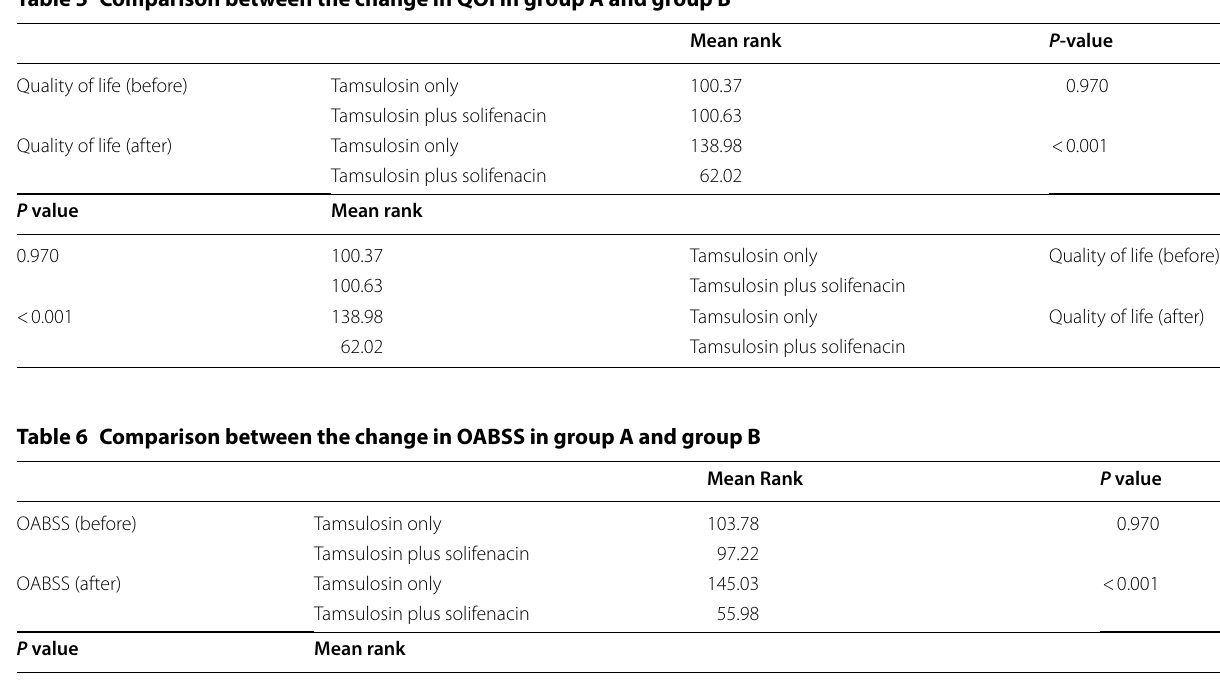
Asterisk represents significant difference between both groups: P value < 0.05 was considered statistically significant Table 5 Comparison between the change in QOl in group A and group B